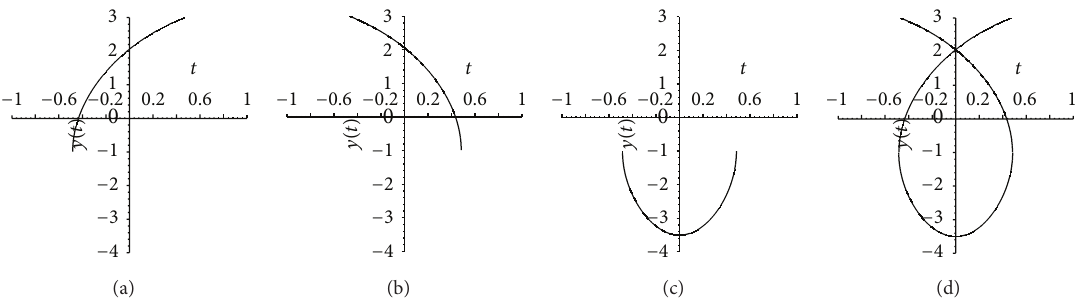
Figure 5: The profiles of waves when 𝛼 < 0 , (𝑟,𝛽) ∈ 𝐿 3− . (a) shows the kink wave corresponding to the unstable manifold. (b) shows the kink wave corresponding to the stable manifold. (c) shows the breaking wave corresponding to the open curve passing through the point (𝜓 ,0) . (d) shows the wave profile of three curves—loop solution. 𝐴 + +